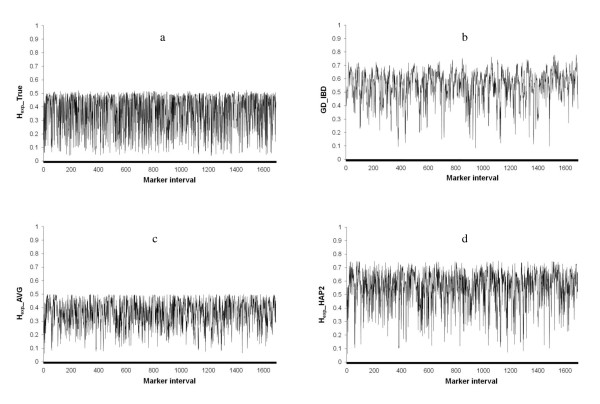
a, b, c, d - Distribution of the estimated genetic diversity across the simulated genome. (a) True genetic diversity calculated by expected heterozygosity for the ungenotyped marker loci within the marker interval (Hexp_TRUE); (b) Estimated genetic diversity with IBD probabilities between marker haplotypes (GD_IBD); (c) Estimated genetic diversity with expected heterozygosity as an average for the two flanking markers (Hexp_AVG); (d) Estimated genetic diversity with expected heterozygosity for the two flanking markers as a two marker haplotype (Hexp_HAP2).